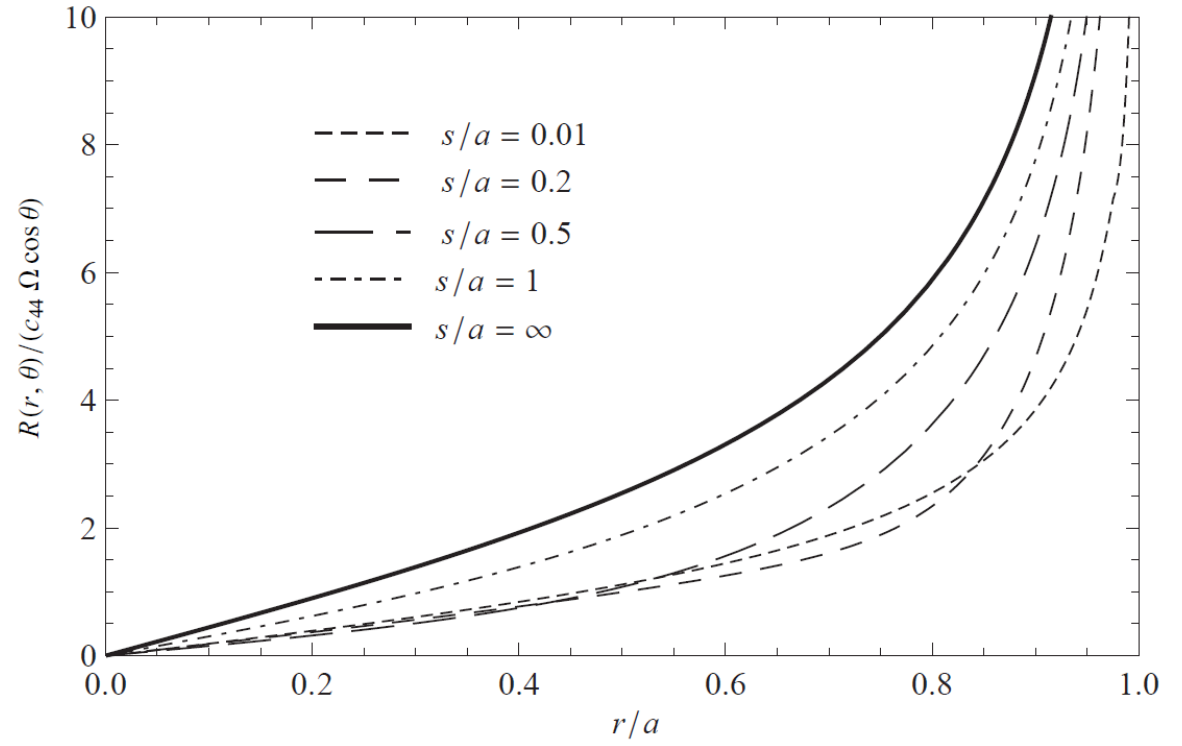
Fig. 3. Contact stress distribution R(r,θ) along the radius of a rigid disk embedded in a Beryl rock half-space.